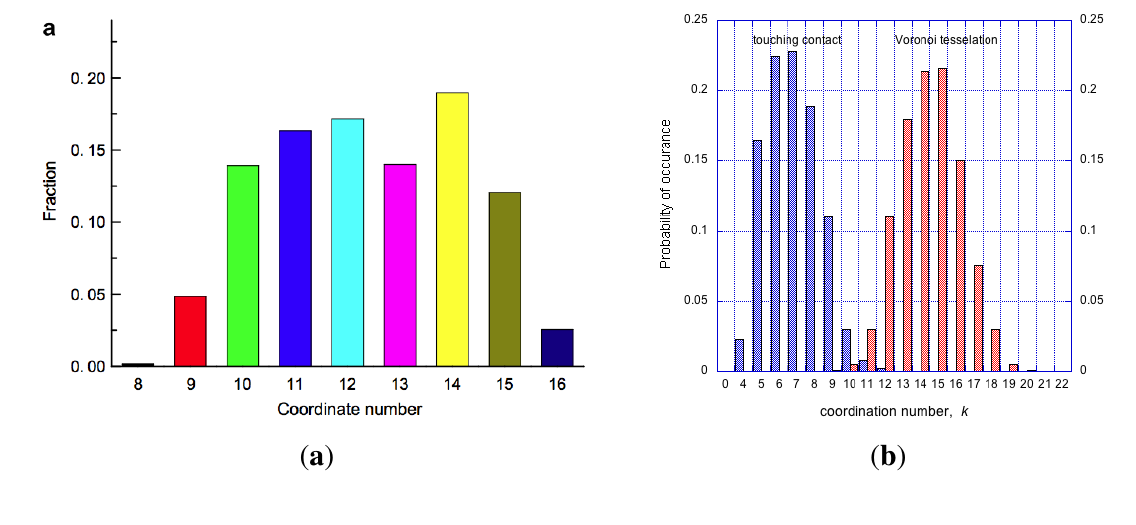
Figure 17. Distribution of coordination numbers in ZrTiCuNiBe metallic glass. On left, measured from molecular dynamics simulation by Hui et.al [106]. On right, coordination number distributions for the same alloy, but in an IAS model [74].